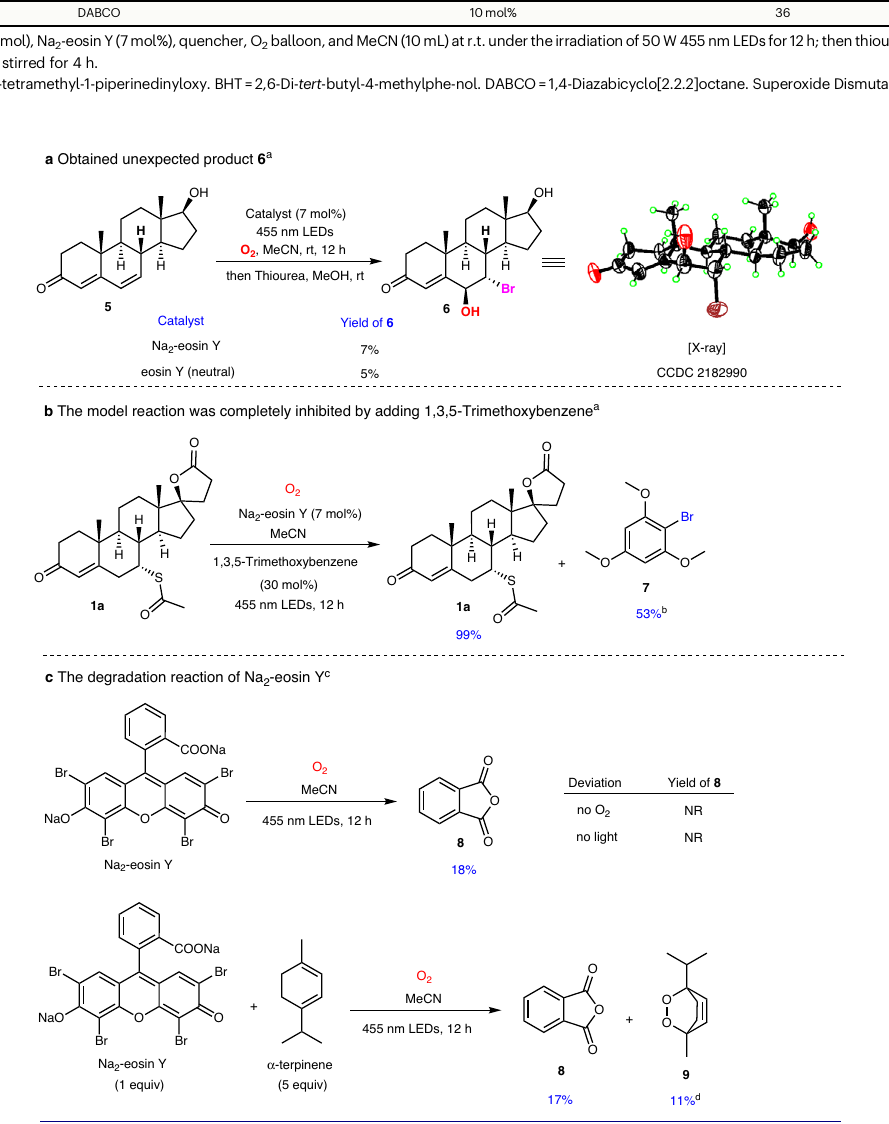
internal standard ( 1 H NMR yield). b Yield relative to 1,3,5-trimethoxybenzene. c Reactions performed on 0.06mmol scale with dimethyl terephthalate as